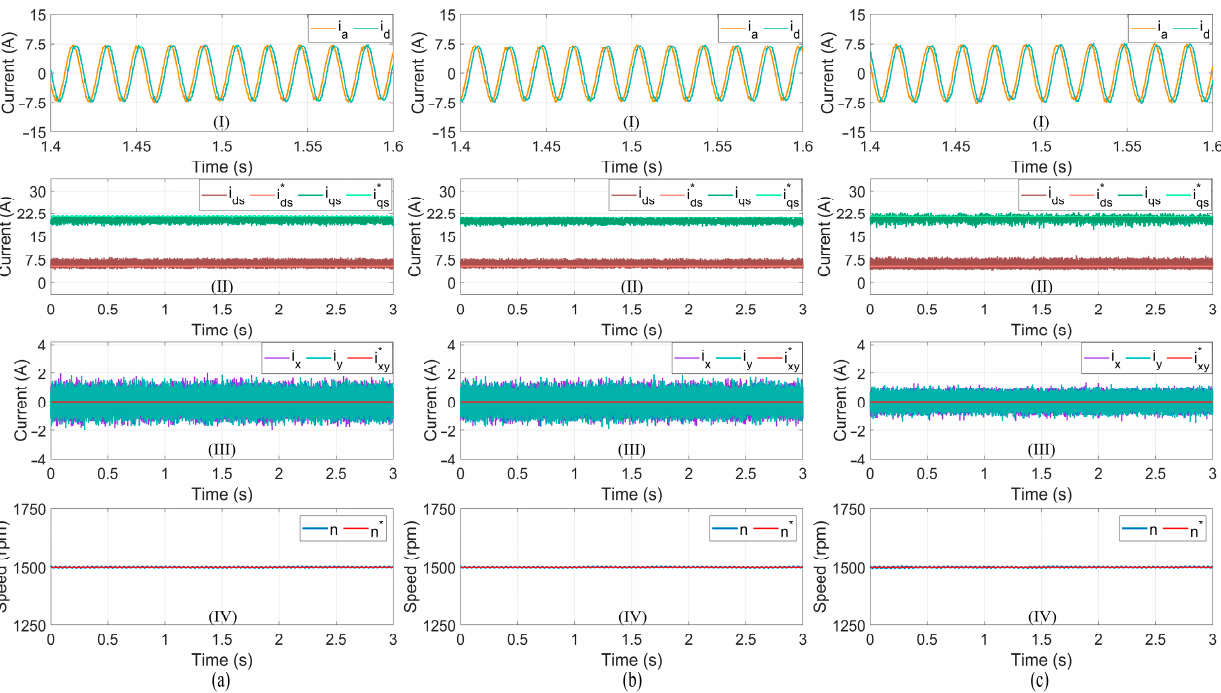
Figure 11. Test 4: MPC49 (( a ) plots), MPC13 (( b ) plots), and the proposed HMPCC (( c ) plots)). From top to bottom: (I) the a and d phase currents; (II) d and q currents; (III) x and y currents; (IV) motor speed.